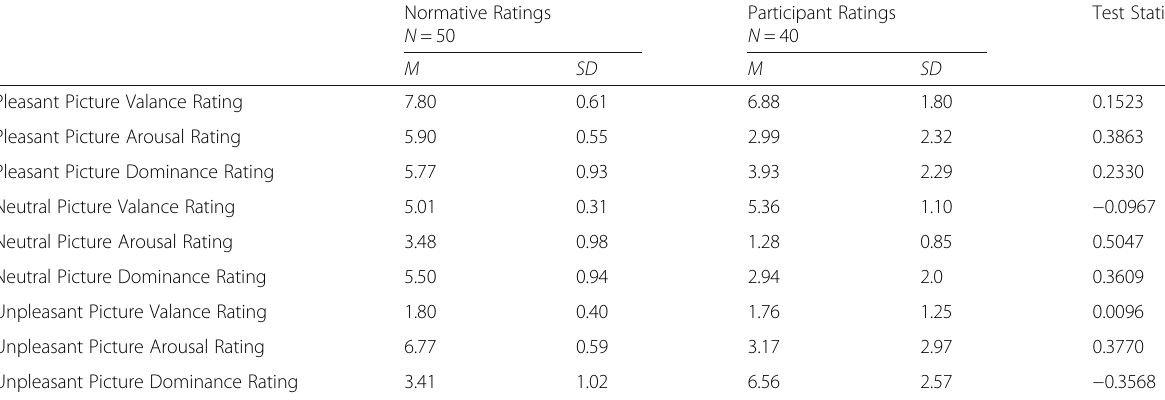
Table 3 Affective ratings of picture stimuli from IAPS